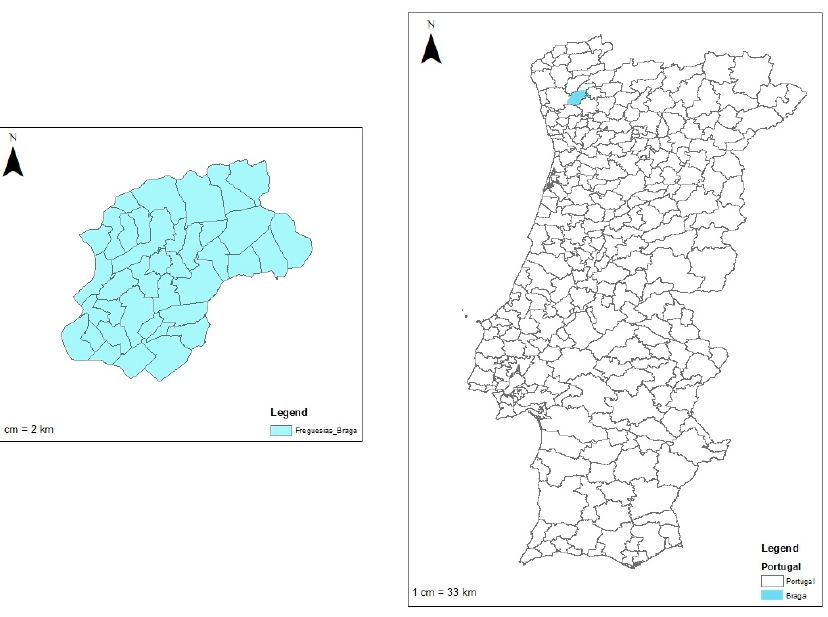
Figure 2. The location of the study site.